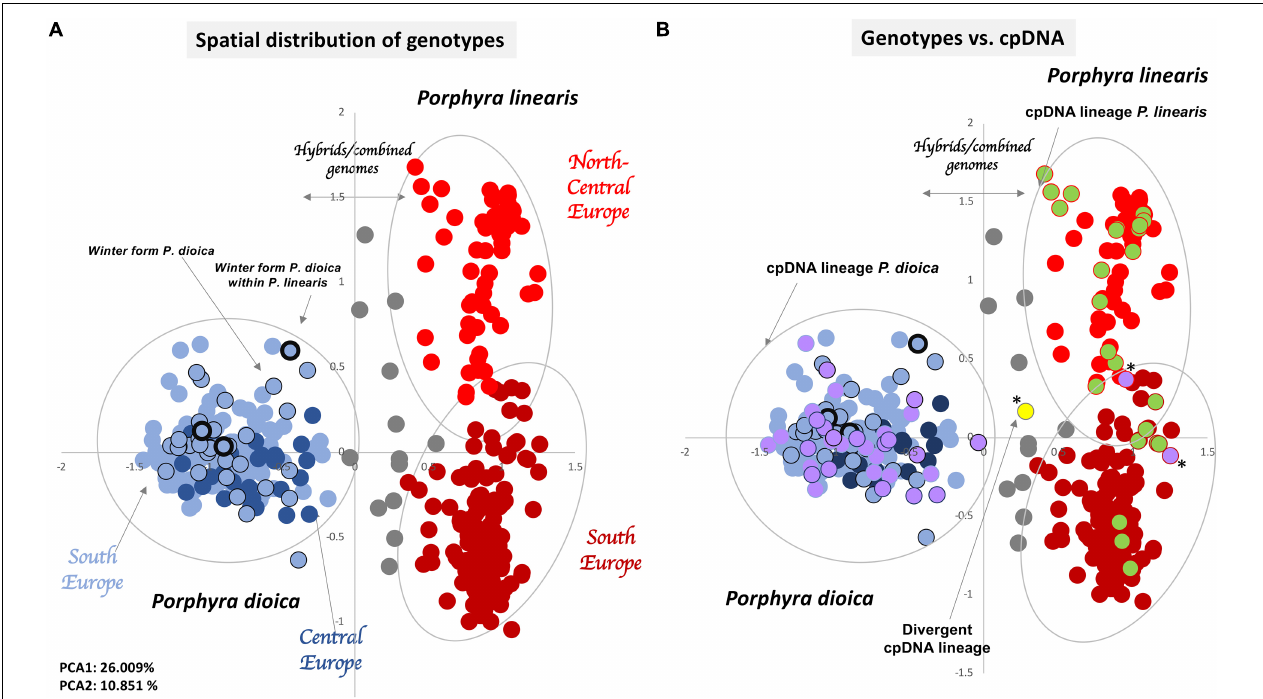
FIGURE 6 | Spatial representation of genetic differentiation of the 442 genotypes. Principal component analyses (PCA) based on allelic variation at 10 loci. (A) PCA with Porphyra linearis genotypes in red (north Europe light red, south Europe dark red), Porphyra dioica genotypes in blue (central Europe dark blue, south Europe light blue), Winter form of P. dioica in blue surrounded by a black circle and hybrids or genotypes with combined genomes in gray. (B) PCA comparing genotypes vs. cpDNA rbcL sequences for each genotype found, with genotypes having rbcL sequences within the cpDNA lineage of P. linearis in green, genotypes having rbcL sequences with the cpDNA lineage of P. dioica in purple, and one genotype with a rbcL sequence within the cpDNA lineage of Porphyra spp. (*) Introgressed individuals.